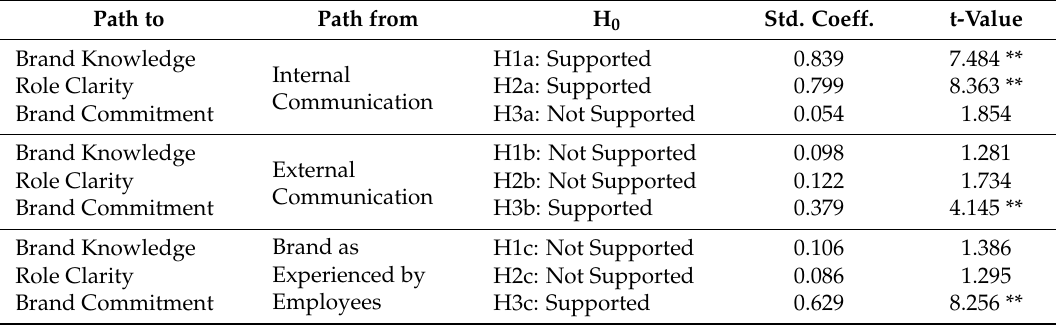
Table 4. Results of path